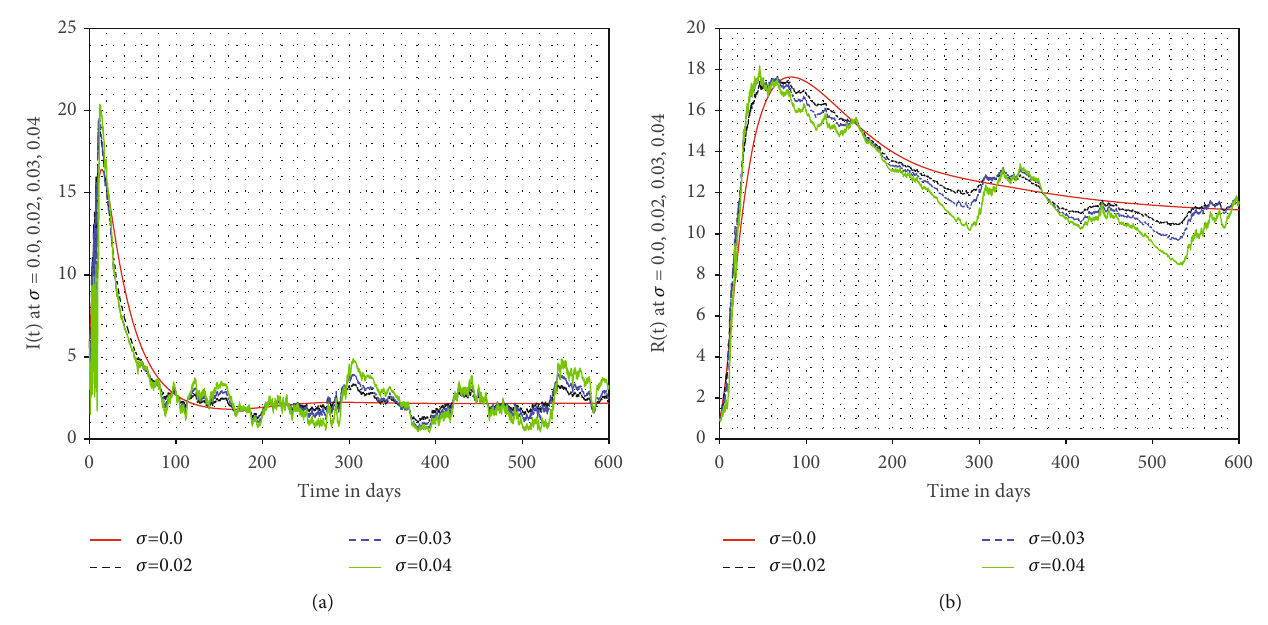
Figure 2: (a, b) I ð t Þ and R ð t Þ for di ff erent values of σ